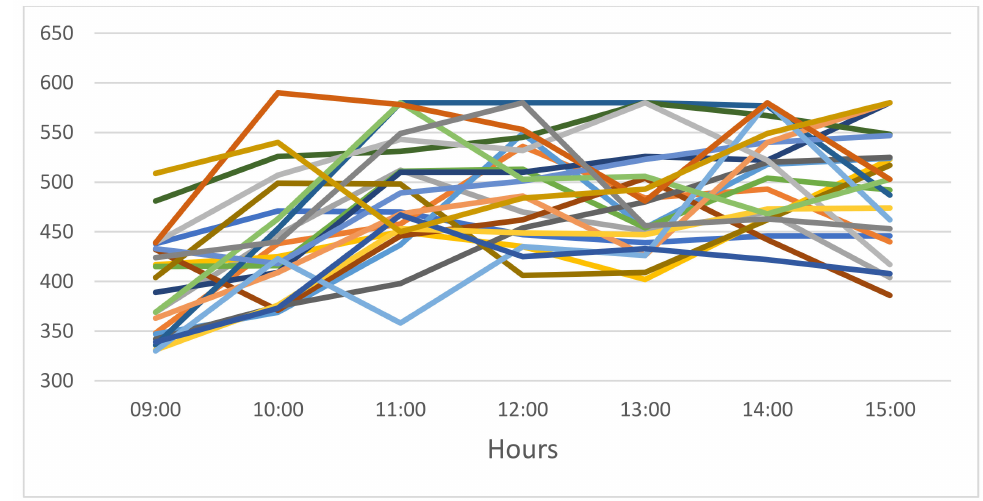
Figure 6. Hourly requests for NNU licenses with each color representing a different day in